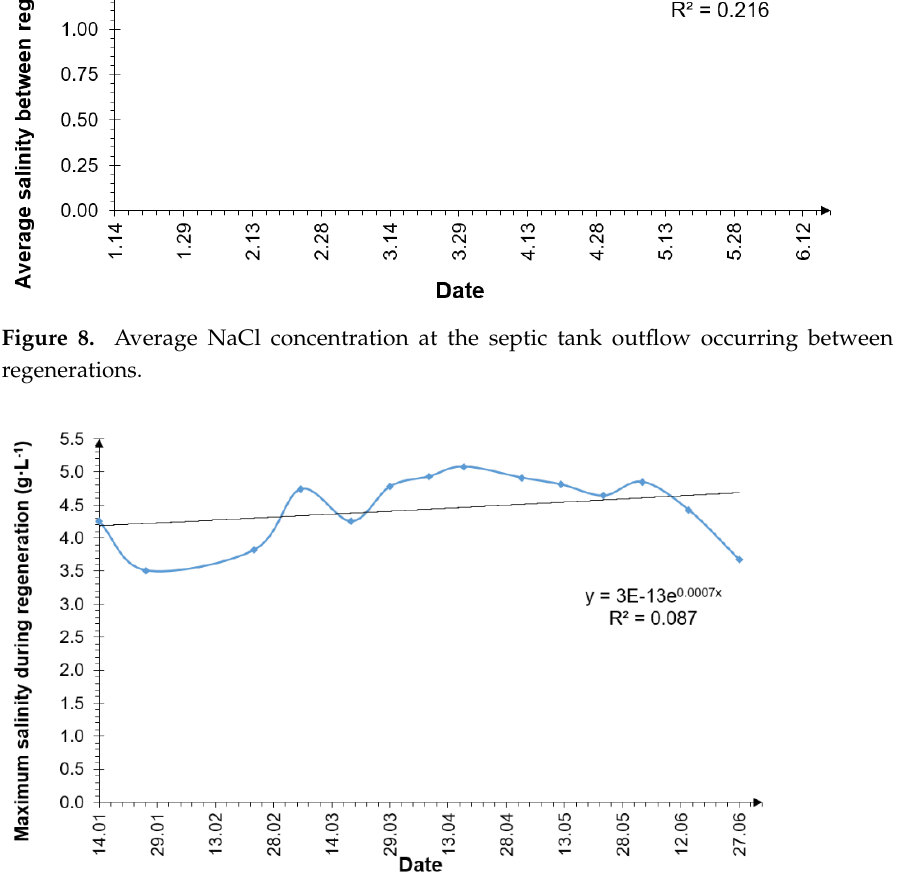
Figure 9. Maximum NaCl concentration at the septic tank outflow during water softener regenera- tion.